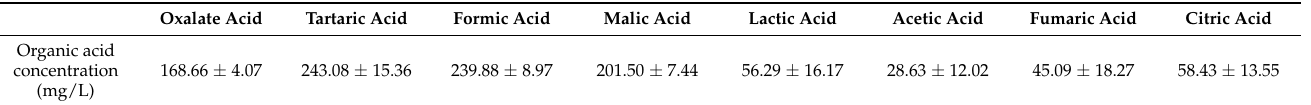
Table 3. Types and concentrations of organic acids secreted by PSF7.